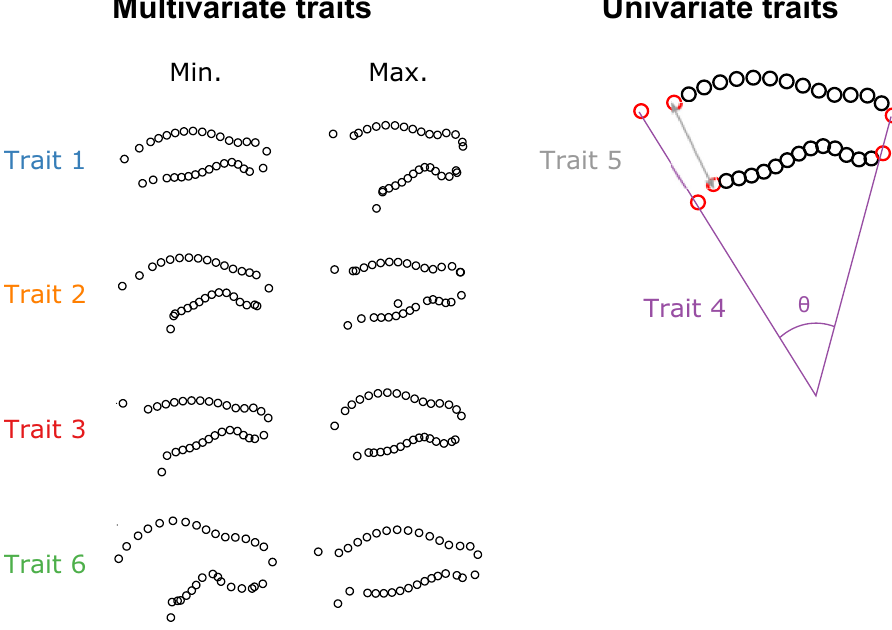
Fig 2. Schematic depiction of the phenotypic traits used in this study. For each multivariate trait, the whole range of corolla shape variation is represented by the landmarks (red dots) and semi-landmarks (black dots) of the corolla profile; the minimum and maximum shapes correspond to the most extreme values observed in the corresponding Principal Component Analysis (PCA) (see [63]). Under the univariate traits is an example of how measurements were performed from landmarks positions on a specific floral shape from landmarks (red